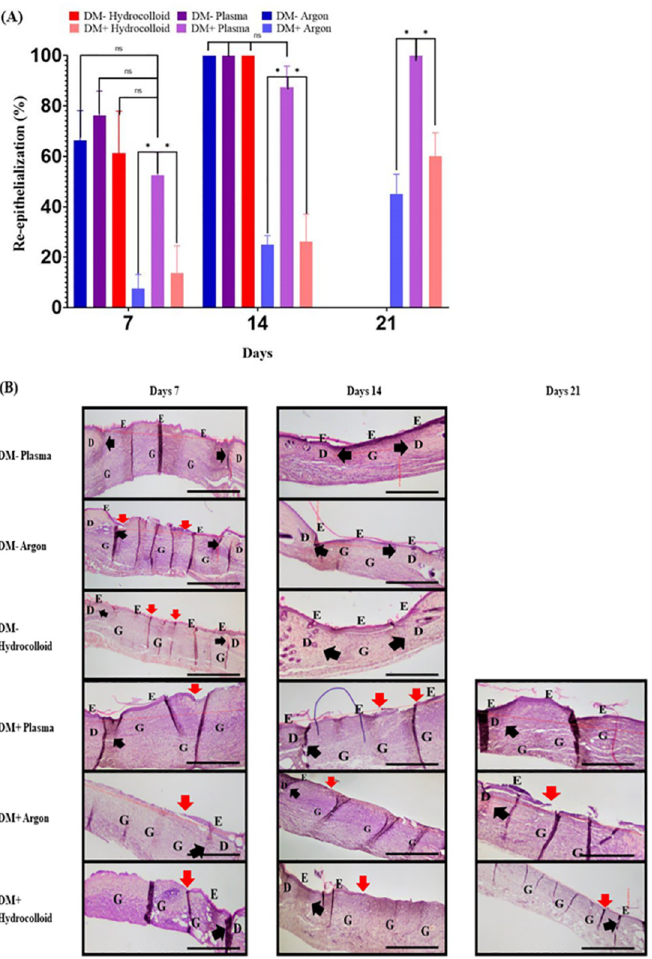
Fig 8. Percentage of re-epithelialization in wound healing. The percentage of re-epithelialization in wound healing on the skin of the dorsum. (A) The percentages of re-epithelialization in the DM- and DM+ groups on days 7, 14, and 21 are shown in box graphs. Values are expressed as the mean ± SD, ANOVA, Tukey-Kramer � p < 0.01. (B) Histological features of wounds stained by hematoxylin and eosin. Red arrows indicate the tip of the re-epithelium (E) covering the wound surface. Block arrows indicate the edge of the wound, the boundary between the normal dermis (D) and granular tissue (G). The distances between the edges of wounds were markedly shorter in DM- mice than in DM+ mice. Wound surfaces on DM- mice on day 14 were already covered by a re-epithelium. Although wound surfaces in the DM+Argon and DM+Hydrocolloid groups were not yet covered by a re-epithelium on day 21, those of the DM+Plasma group were. Scale bar, 500 μ